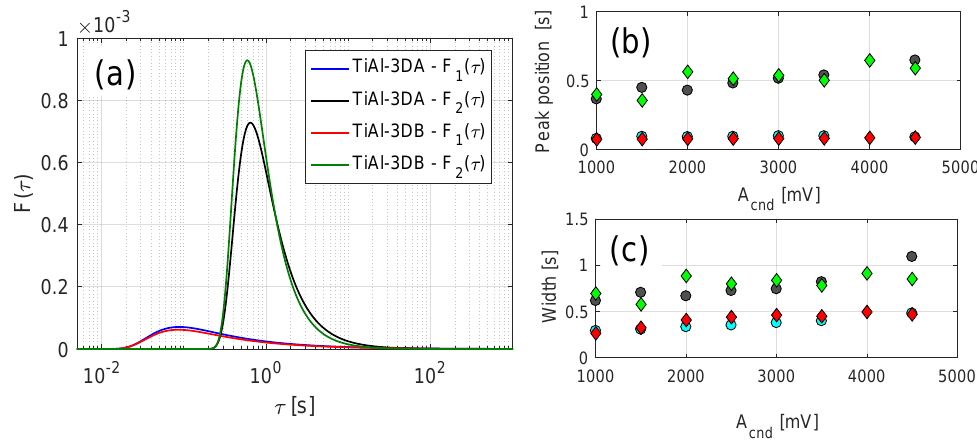
Figure 12. Effects of porosity on the relaxation process. ( a ) Distribution of relaxation times for two samples with different porosity level; ( b ) Peak position vs. conditioning amplitude; ( c ) Width vs. conditioning amplitude. Both the peak position and width are not affected by the increase of porosity. A slight increase in amplitude in correspondance to the peak of the second weibull distribution F 2 ( τ ) could be noticed, but data do not allow to establish with certainty whether the increase in relaxation strength is due to the increased porosity or to small differences of the two